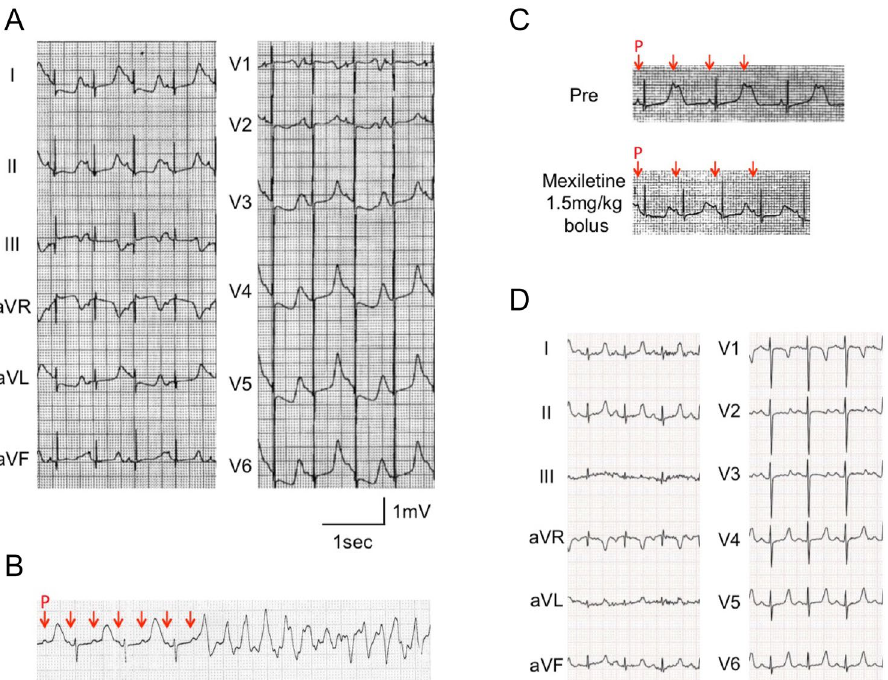
Figure 1. Electrocardiograms (ECG) of a 2-month-old female infant with Timothy syndrome, showing ( A ) T-wave alternans, ( B ) 2:1 atrio-ventricular block and torsades de pointes, ( C ) before and after the intravenous mexiletine, and ( D ) after oral administration of mexiletine and propranolol. Red arrows in ( B ) and ( C ) indicate P